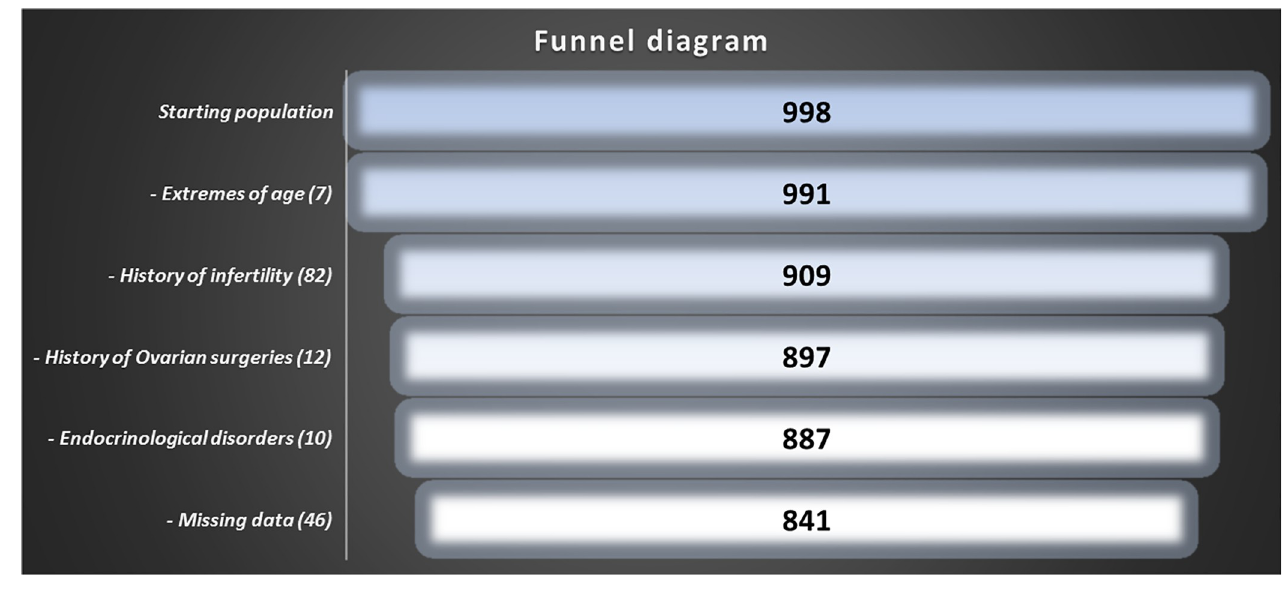
Fig 1. Data selection procedures and sample